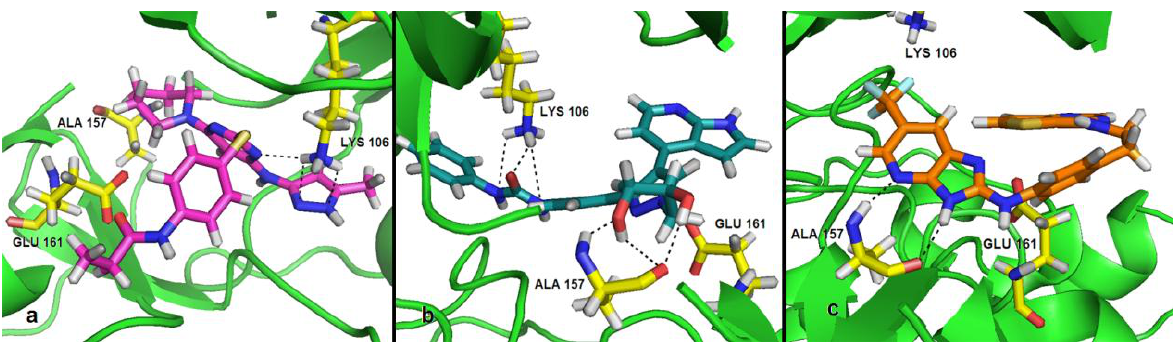
Figure 6. Stereoview of the docked conformations of compounds 25, 40 and 105, respectively, in the active site of Aurora B kinase. The hydrogen bonds are shown by broken lines. Compounds 25, 40 and 105, colored purple, cyan and orange, are presented in pictures a, b and c, respectively. The important amino acid residues, Lys106, Ala157 and Glu161 (stick rendering) are colored by atom type (C, yellow; N, blue; H, white; O,